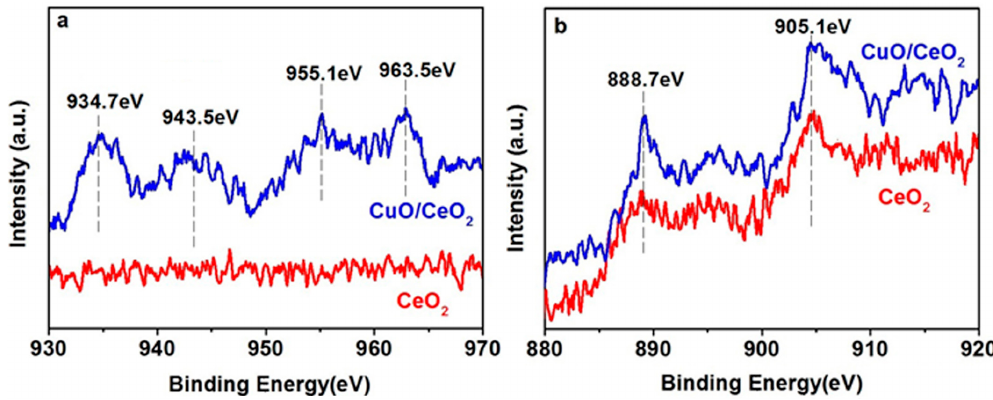
Figure 2. X ‐ ray photoelectron spectroscopy (XPS) spectra of ( a ) Cu 2p and ( b ) Ce 3d.